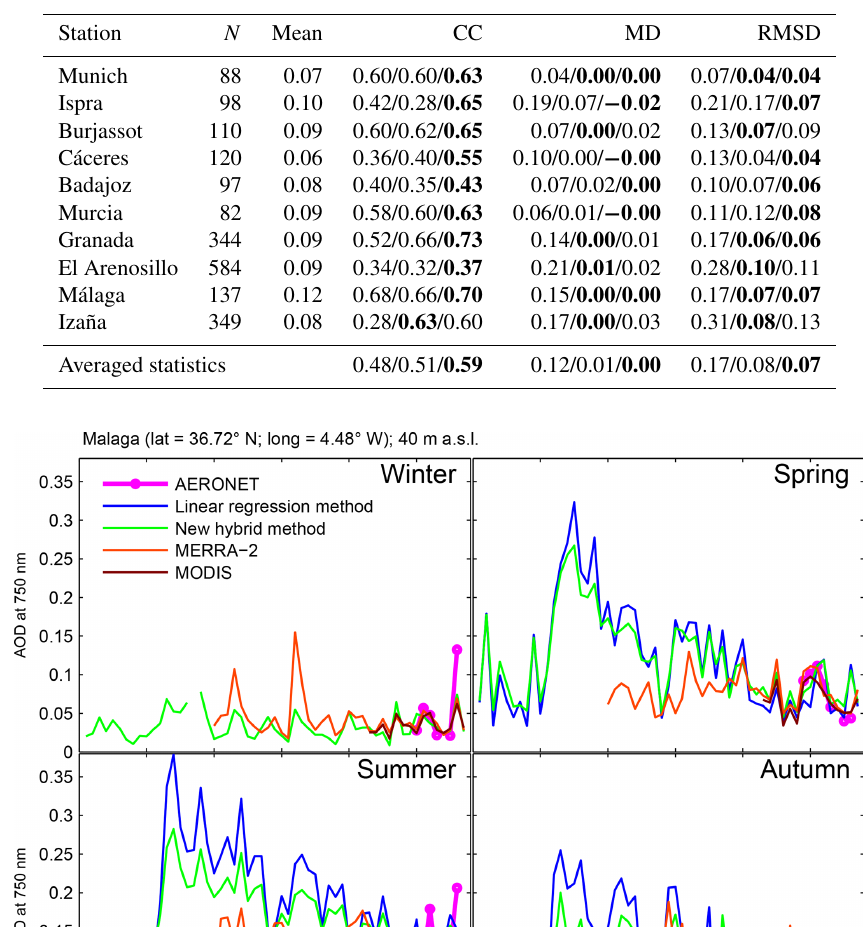
Table 4. Statistical indicators for each station. N is the number of data pairs. Mean is the average of AERONET measurements. MD is the mean difference. RMSD is the root mean square difference. The first value is the PBM, the second one is the LRM and the third one is the NHM. The best performance is in bold.